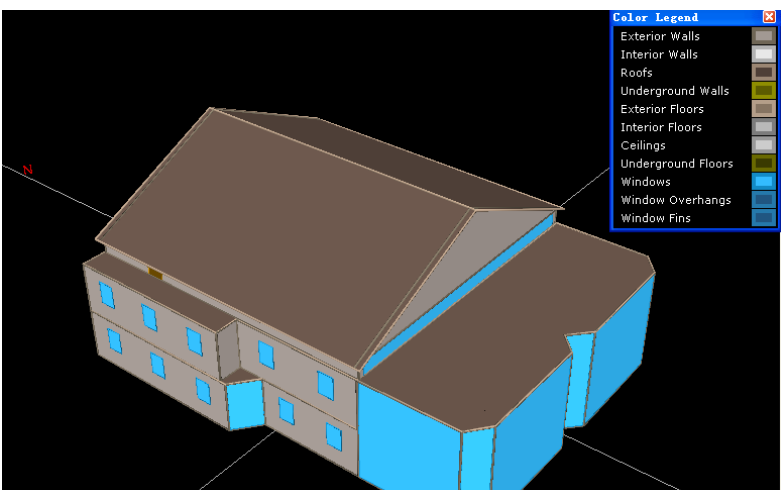
Figure 2. The eQUEST building